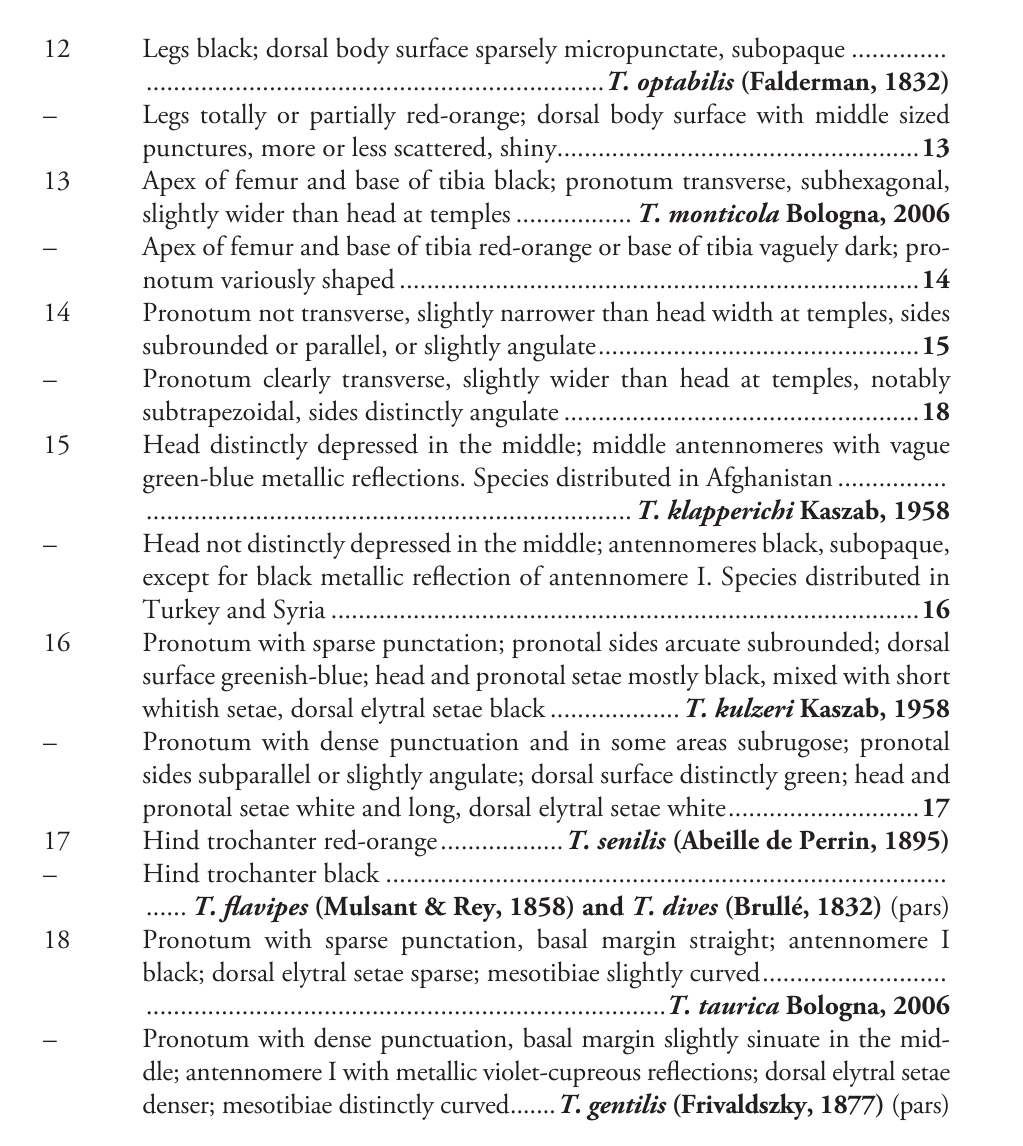
– Pronotum with sparse punctation, basal margin straight; antennomere I black; dorsal elytral setae sparse; mesotibiae slightly curved ........................... – Pronotum with dense punctuation, basal margin slightly sinuate in the mid- dle; antennomere I with metallic violet-cupreous reflections; dorsal elytral setae denser; mesotibiae distinctly curved ....... T. gentilis (Frivaldszky, 1877)